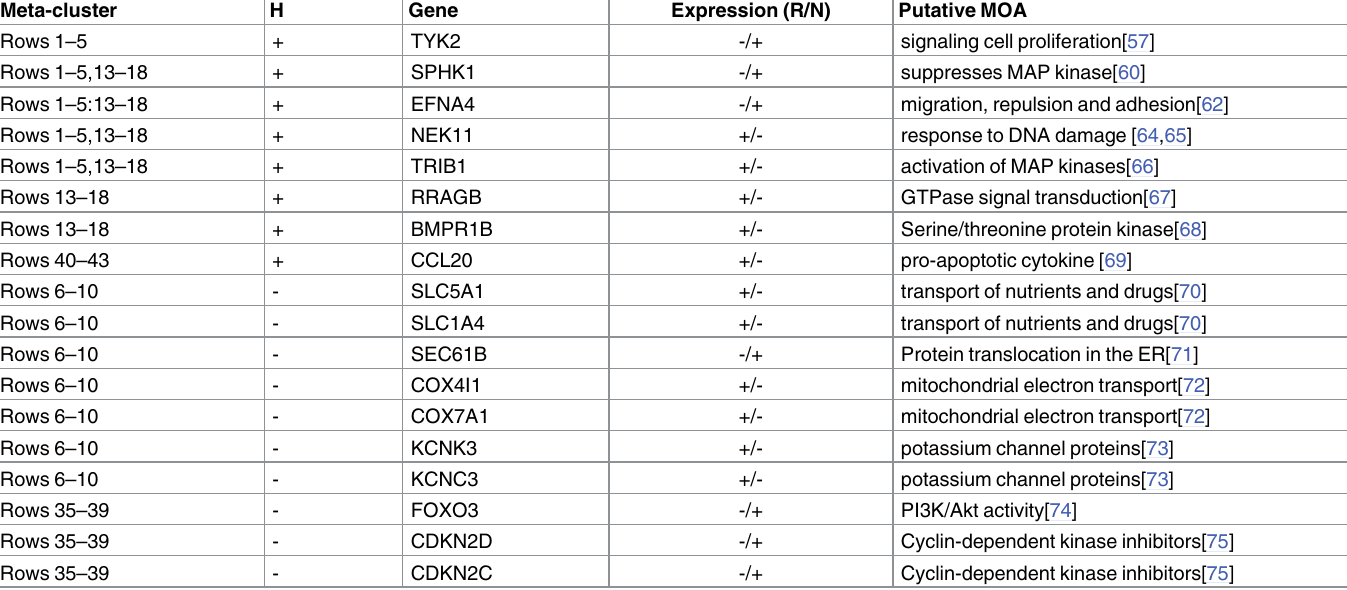
Table 2. Summaryof the potential sorafenib biomarker genes identified using pathway fitness scores. Column1 identifiesthe meta-clusteras viewed in Fig 7 . Column2 list whetherthe pathway fitness score is positive (+) or negative(-). Column3 lists the gene. Column4 lists the differentialgene expression comparing responders(R) to non-responders(N). Over expressionin respondersis indicatedby a +/-, and vice versa for over expressionin non-responders. Column5 lists the putative